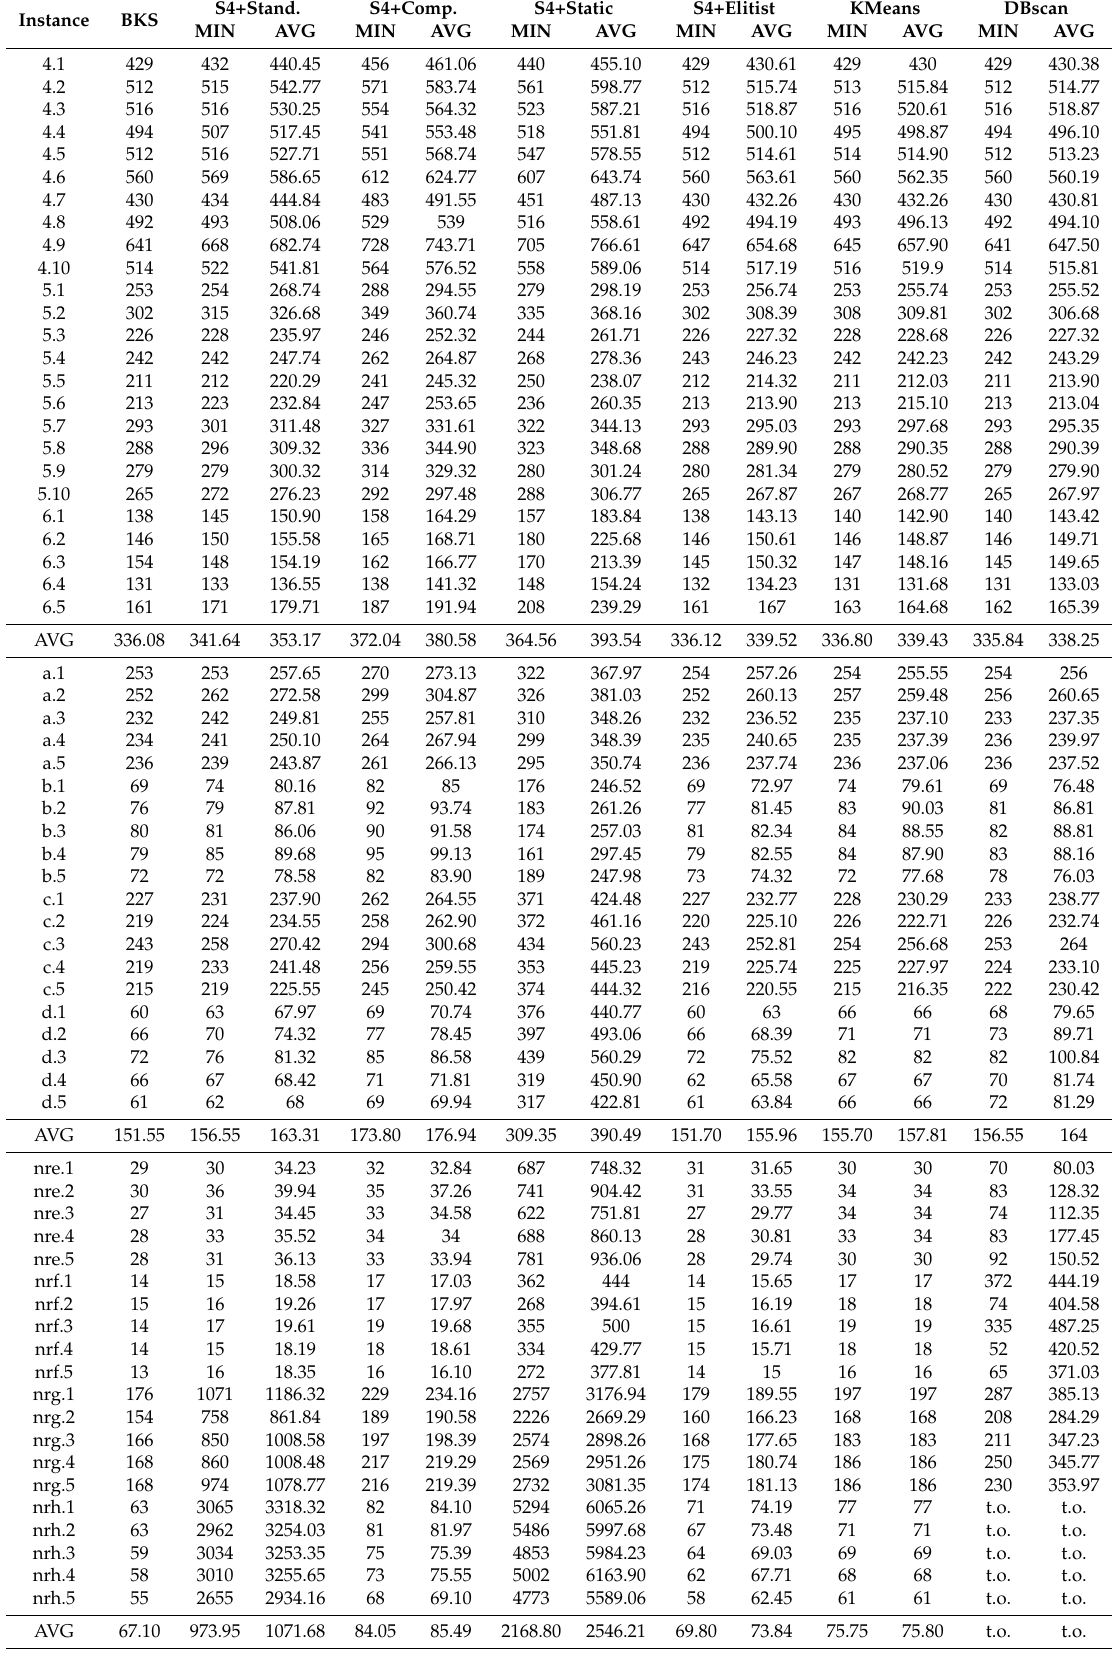
Table A4. CSA/SCP—SShape 4—Two-steps vs. KMeans vs. DBscan (t.o = time